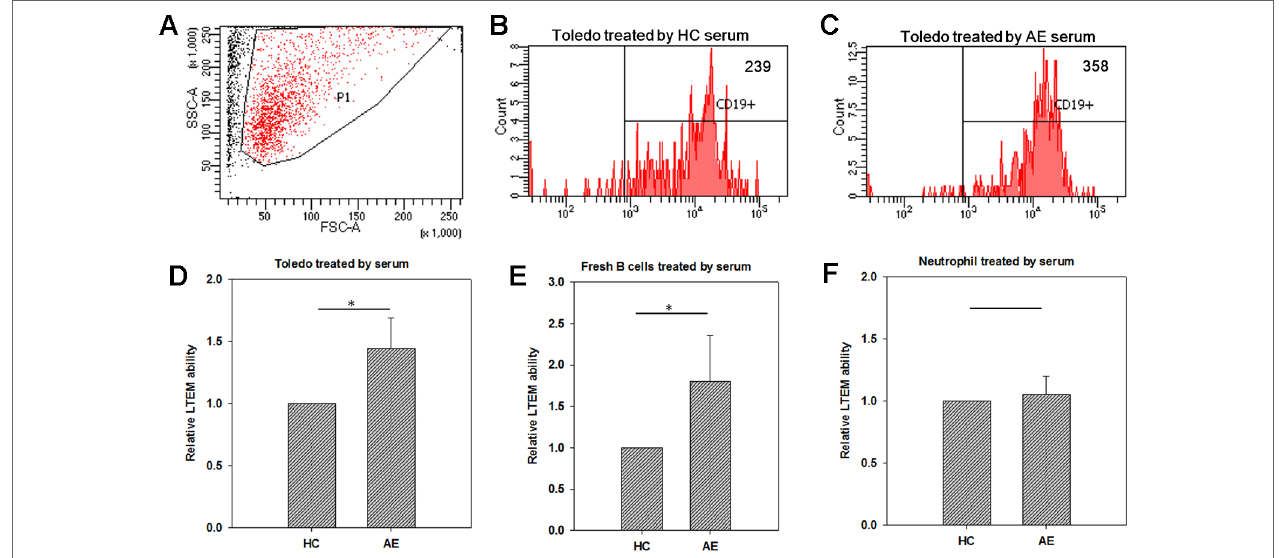
FigUrE 2 | Using in vitro leukocyte transendothelial migration (LTEM) assay to investigate whether serum promotes leukocyte to penetrate BBB endothelial layer. We developed the specific LTEM model to study autoimmune encephalitis (AE) by making the endothelial layer with the cells of BBB endothelial cell line (hCMEC). (A) We first determined the specified FSC-A and SSC-A values which would be applied to gate the cells with LTEM assay. (B) When treated with HC serum, 239 of the treated Toledo cells were detected. (c) When the Toledo cells were treated with AE serum, we collected 358 ones. (D) AE serum significantly promoted Toledo cells to penetrate the BBB endothelial layer by almost 1.5 times than HC serum did (N = 4). (E) When fresh B cells were applied to replace Toledo cell, consistent and significant result was observed (N = 4). (F) No significant difference was observed when neutrophil-like cells were applied (N = 4). Data was presented as mean ± S.D. * denoted p-value <